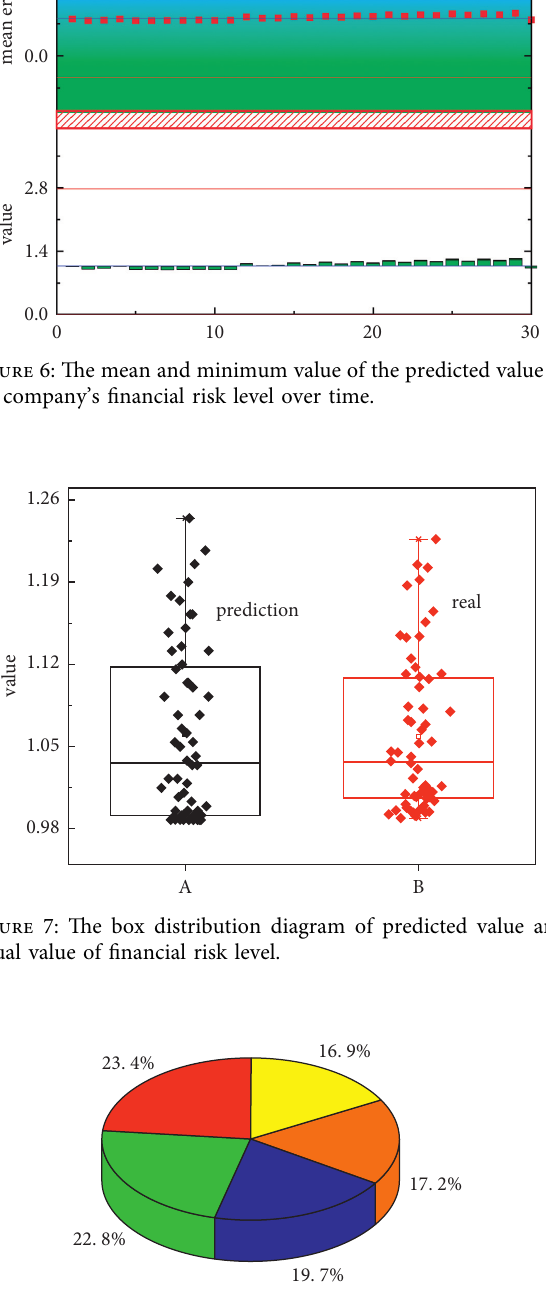
Figure 8: The proportion of the company financial data